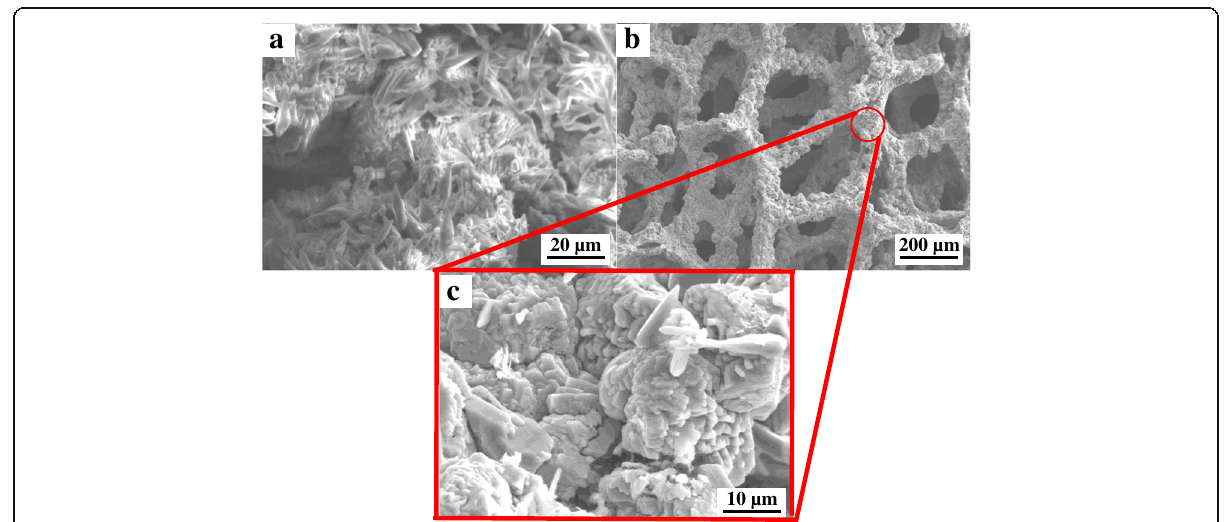
Fig. 5 SEM images of a Co(OH) 2 precursor and pure Co 3 O 4 in b low magnification and c high